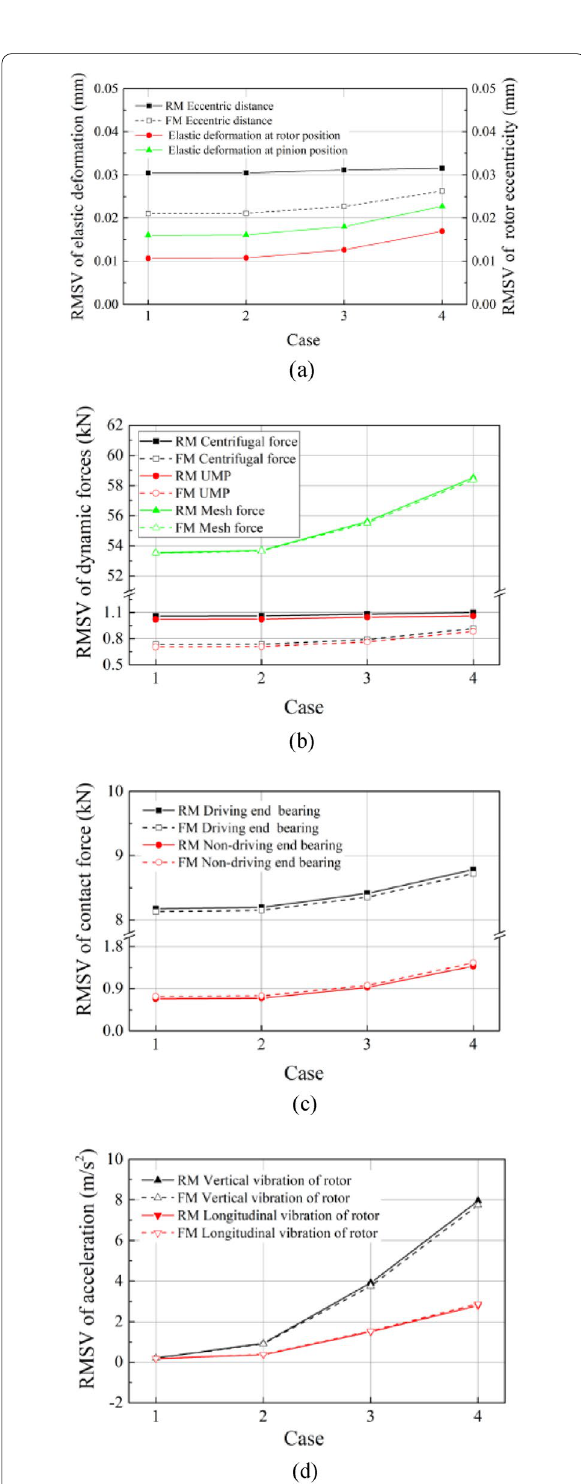
Figure 12 Effect of track irregularity on RMSV of: a dynamic rotor eccentricity and elastic deformation of the shaft, b dynamic forces of traction motor, c roller-race contact forces of motor bearings, and d vibration accelerations of the